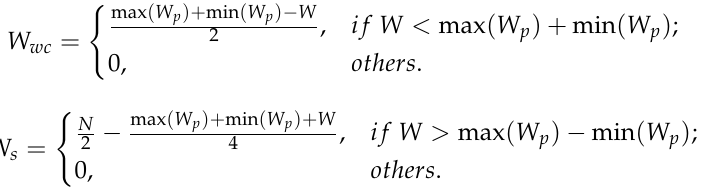
Figure 8. Method to improve the accuracy of sea bottom tracking. ( a ) Coarse segmentation. ( b ) Fine segmentation.